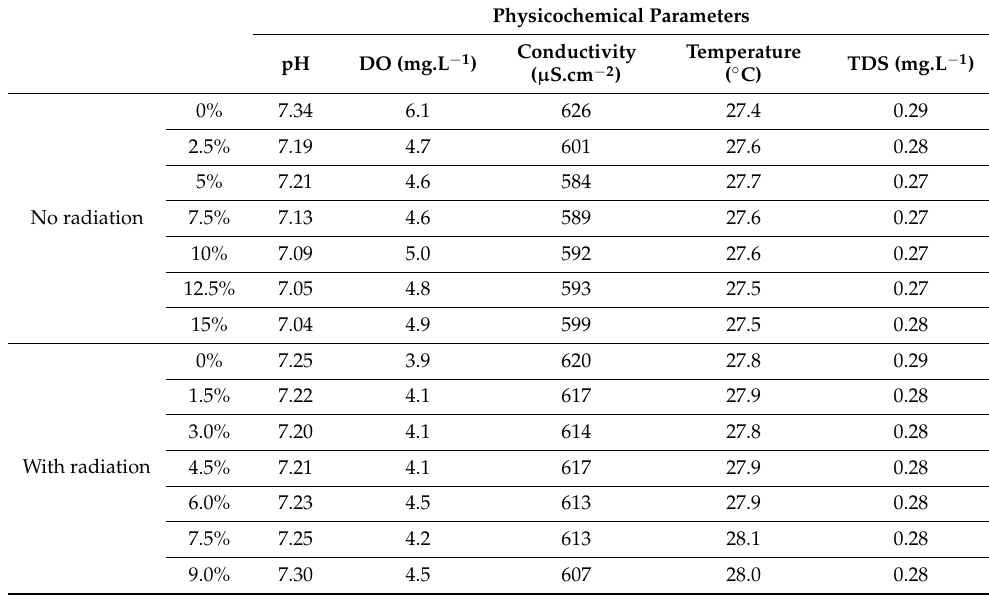
Table 5. Physicochemical parameters for monitoring ecotoxicological